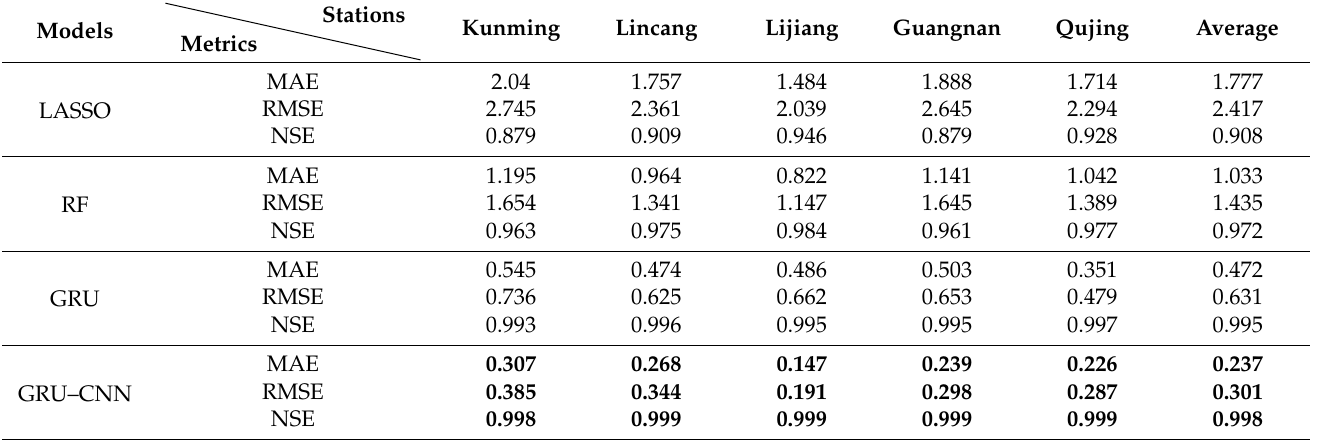
Table 5. Performance of MCI drought index prediction models computed in the 1st month in the